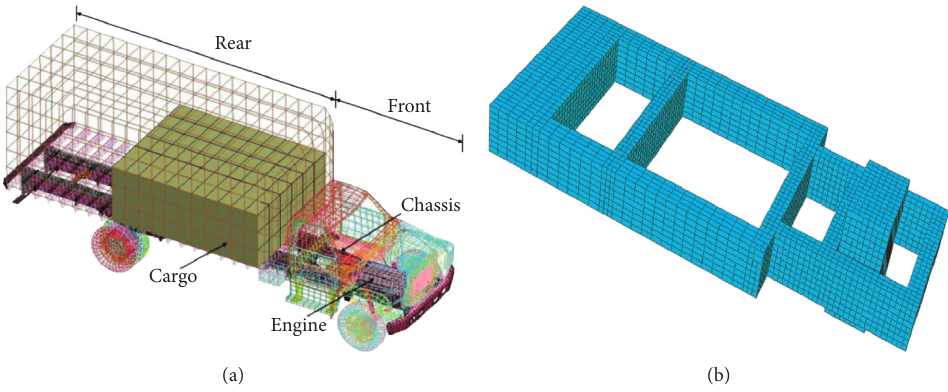
Figure 7: The car model. (a) 1995 Ford F800 truck. (b) Equivalent